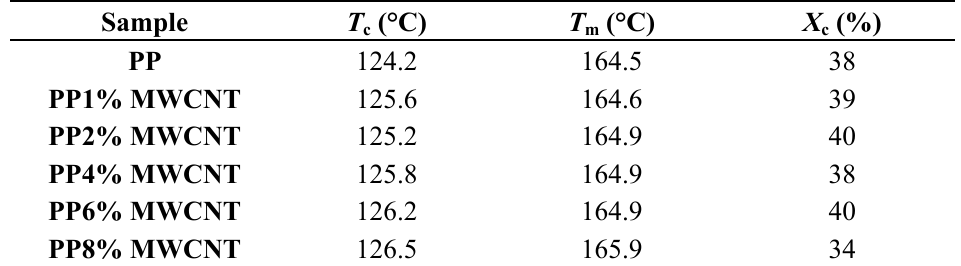
Table 1. Thermal data of neat polypropylene (PP) and Multiwalled Carbon Nanotubes (MWCNT)/PP nanocomposites obtained from DSC results of Figure 1.